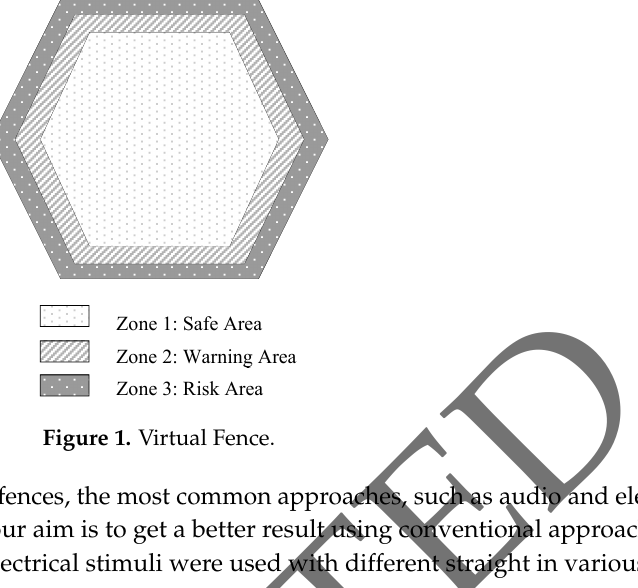
Figure 1. Virtual Figure 1. Virtual Fence.